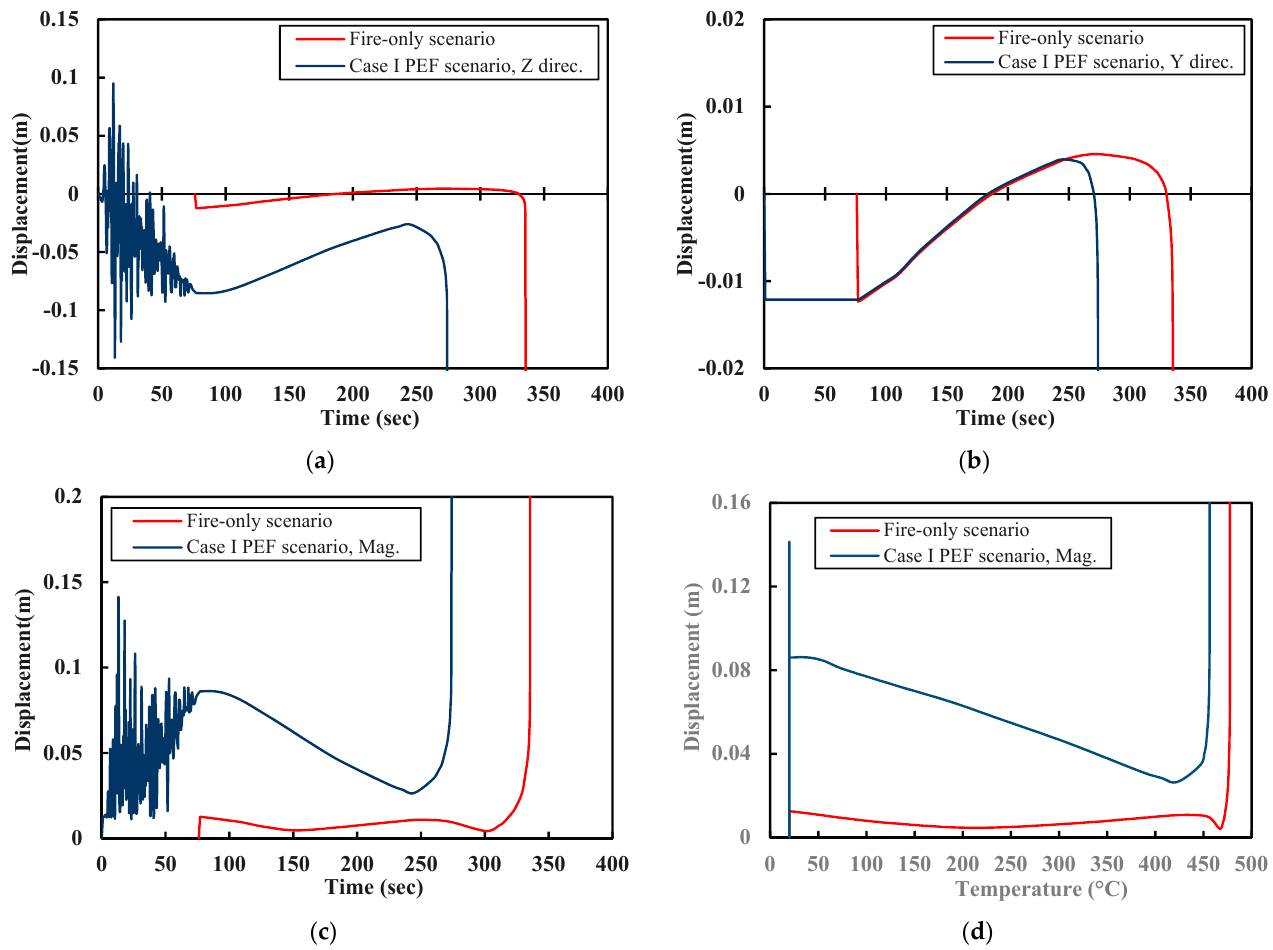
Figure 11. Comparison of the fire-only analysis versus the PEF analysis for Case I including ( a ) the time-mid-span displacement record in the z-direction, ( b ) the time-mid-span displacement in the y-direction, ( c ) the time-mid-span displacement record for the total displacement and ( d ) the temperature-mid-span displacement record for the total displacement .